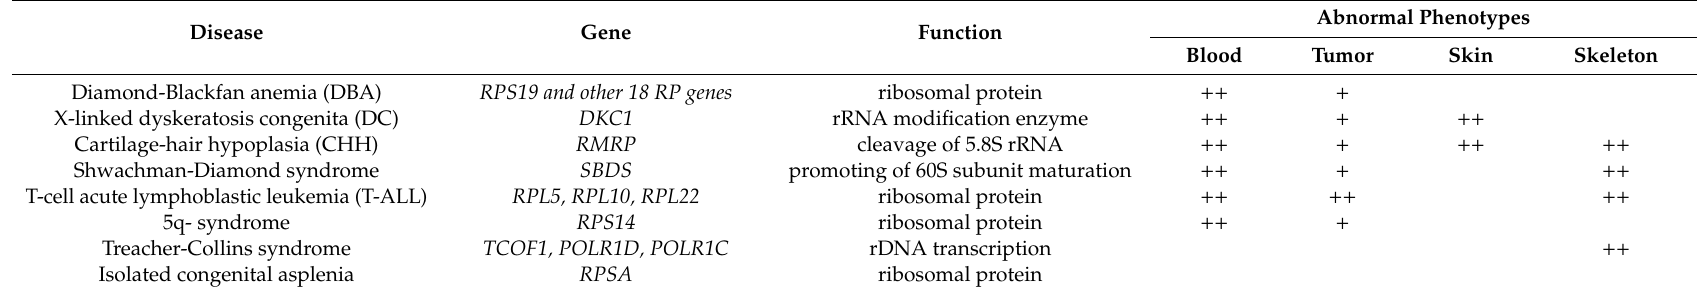
Table 1. Ribosomopathies and causative genes